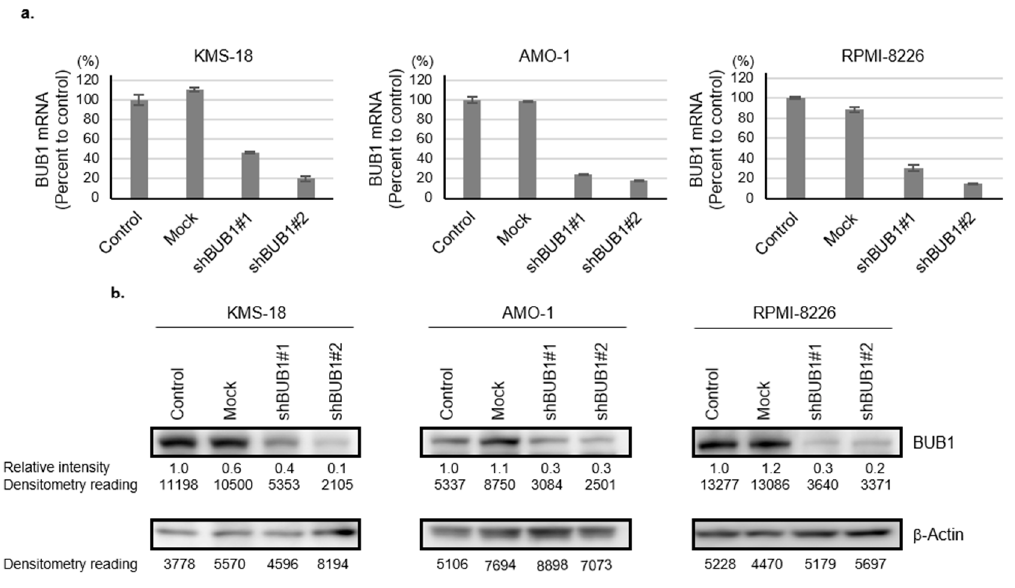
Figure 2. Generation of BUB1-reduced HMCLs. ( a , b ) KMS-18, AMO-1, and RPMI-8226 cells were